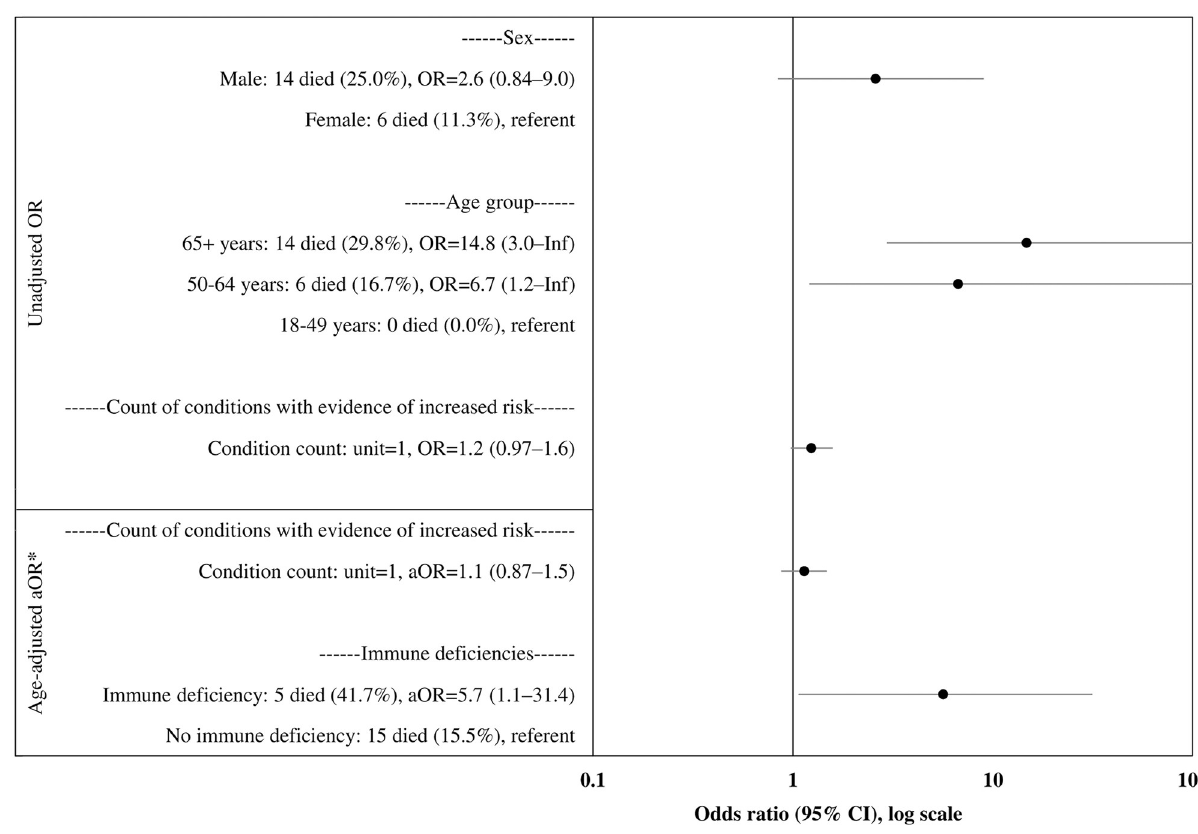
Fig 1. Unadjusted and adjusted odds of death among n = 109 hospitalized patients with COVID-19 in Puerto Rico, March-August 2020. Abbreviations: COVID-19 = coronavirus disease 2019; OR = odds ratio; aOR = adjusted odds ratio; Inf = infinity; 95% CI = 95% confidence interval. � Age-adjusted aORs are not shown for individual conditions listed in Table 1 in which the 95% CI crosses 1.